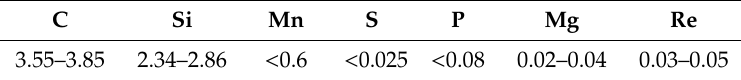
Table 1. Chemical composition of ductile iron (mass fraction (%)).